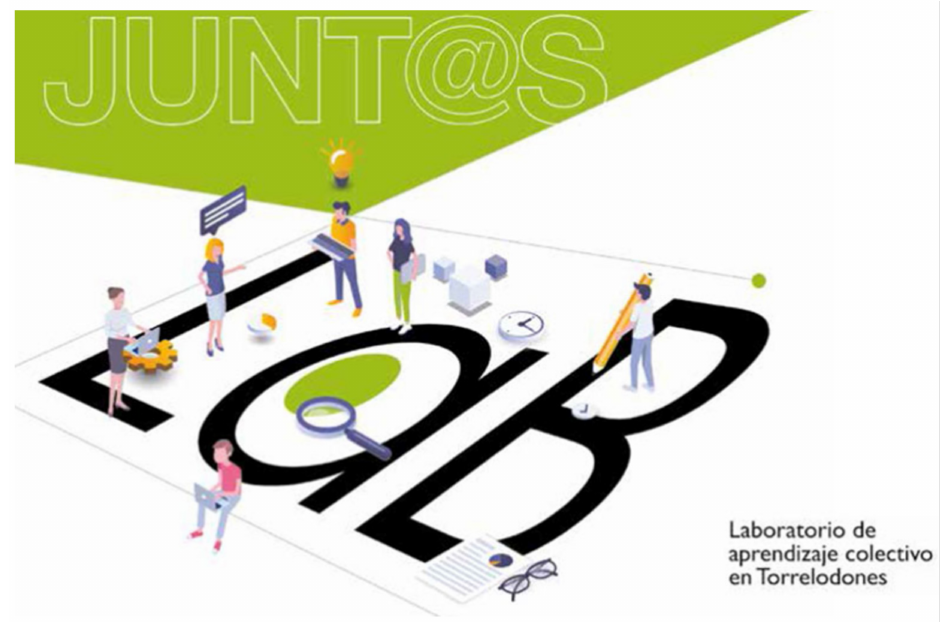
Figure 1. Source: webpage of the local government of